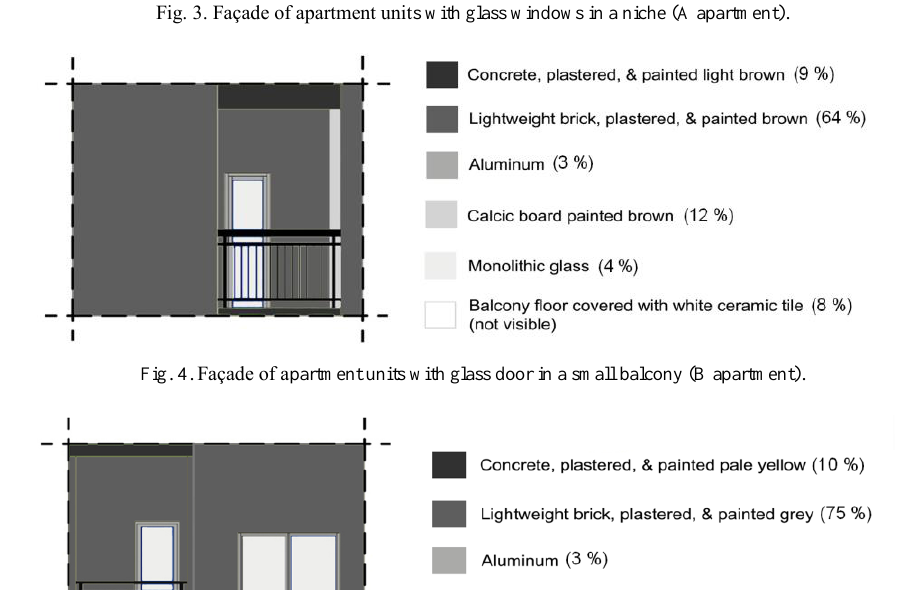
Fig. 3. Façade of apartment units with glass windows in a niche (A apartment).